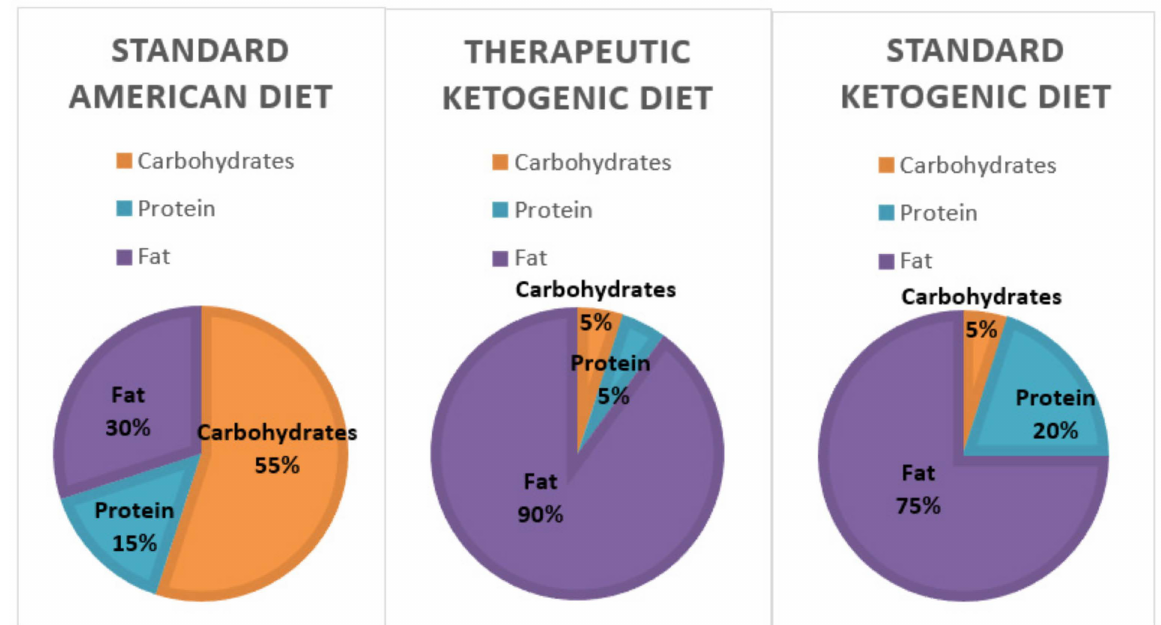
Figure 1. A comparison between the macronutrient breakdown of the standard American diet, therapeutic ketogenic diet, and the typical ketogenic diet. The therapeutic ketogenic diet is typically used in epilepsy and cancer